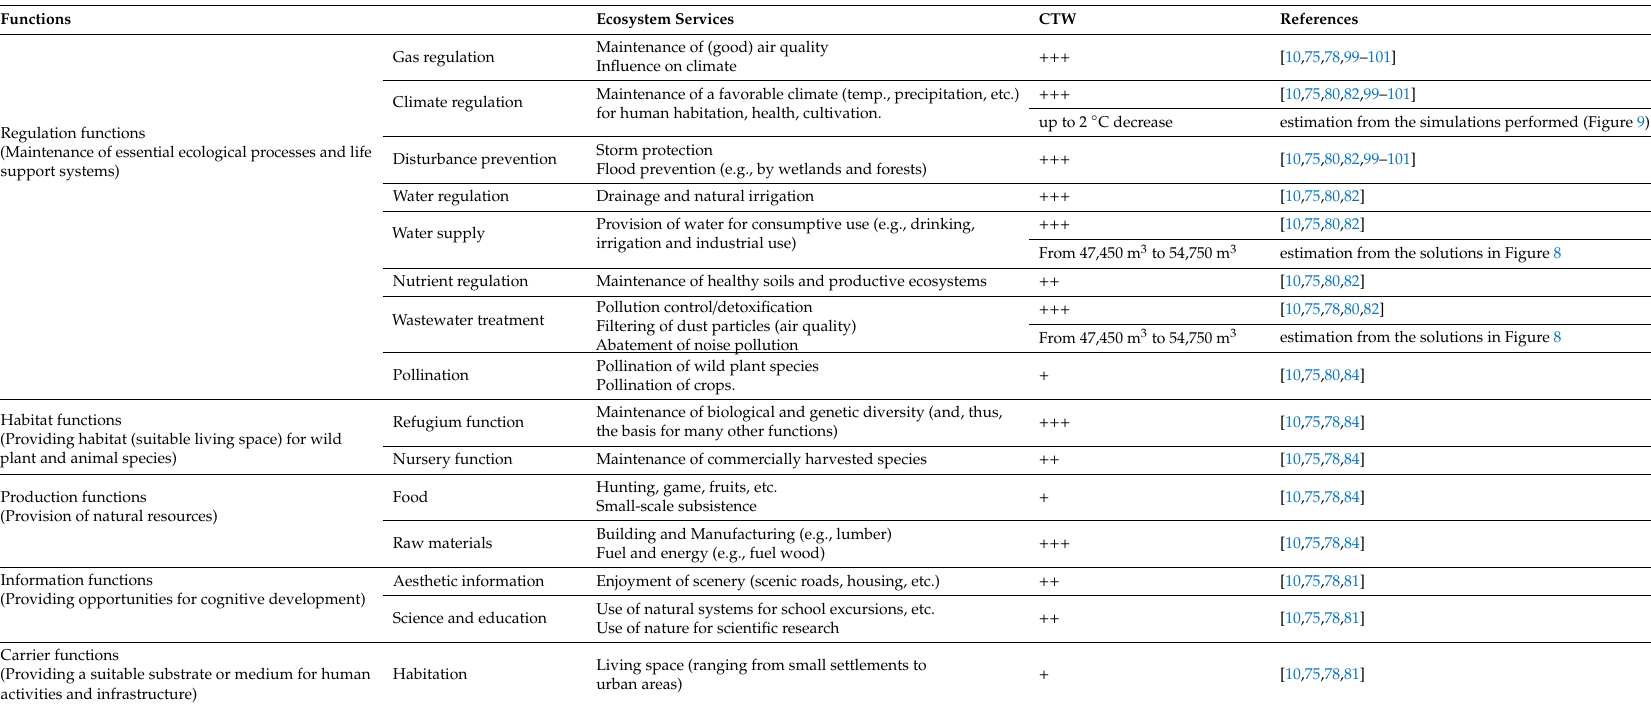
Table 4. Ecological processes and functions linked to the production of good and services identified for CTWs integrated with the GPV systems considered. A qualitative scale, from low ( + ) to high ( +++ ), is employed to indicate an increasing capacity to support ecosystem services [94–98].